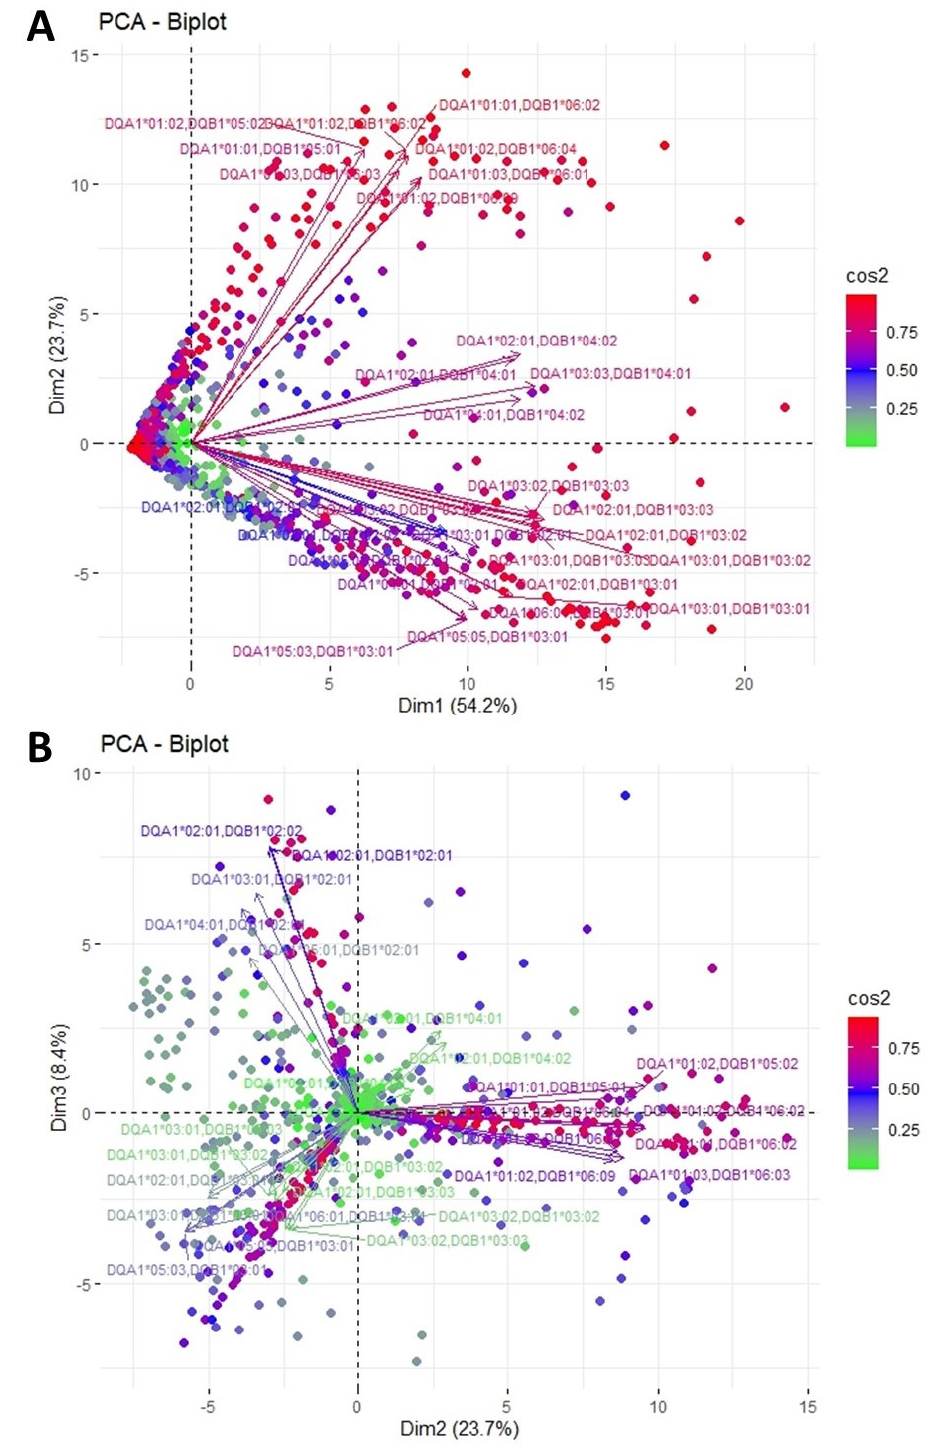
Figure 3. PCA biplot projections of anti-HLA-DQ responses. ( A ) Projection of the first and second eigenvectors of the covariance matrix. ( B ) Projection of the second and third eigenvectors of the covariance matrix. Each arrow represents a specific anti-HLA-DR reaction, while each point indicates individual reactions. Colors of loadings and points represent the cos2 value of the explained variance for variables and individuals, respectively.